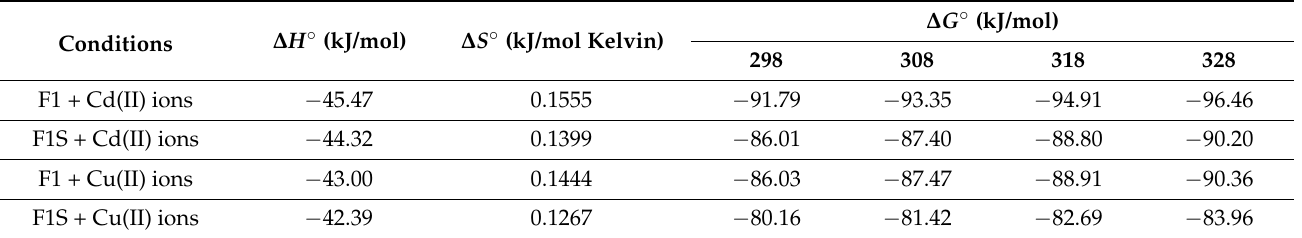
Table 4. The thermodynamic constants for the removal of cadmium and copper ions using the F1 and F1S